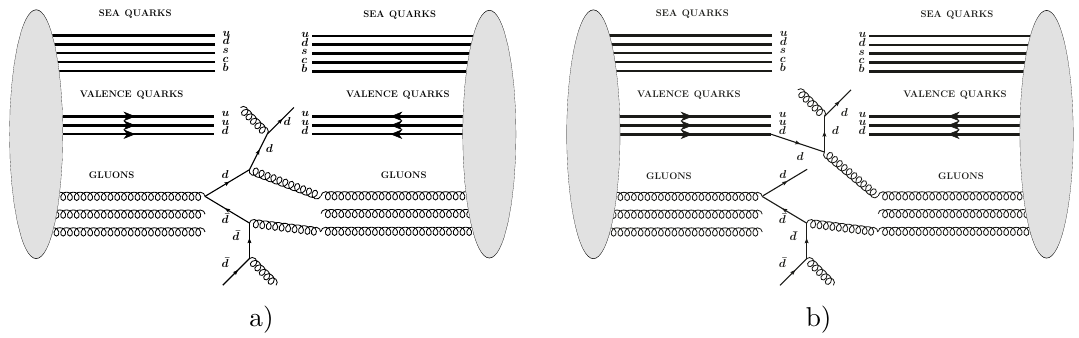
(cid:0) ¯ (cid:1) d g → ¯ d g DPS process in the P YTHIA